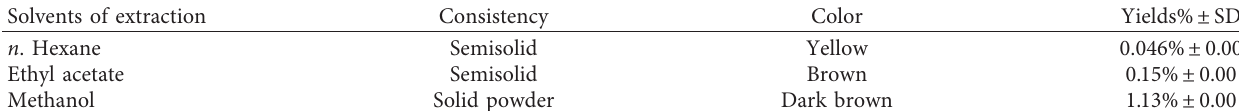
Table 1: The physical properties of Senna occidentalis